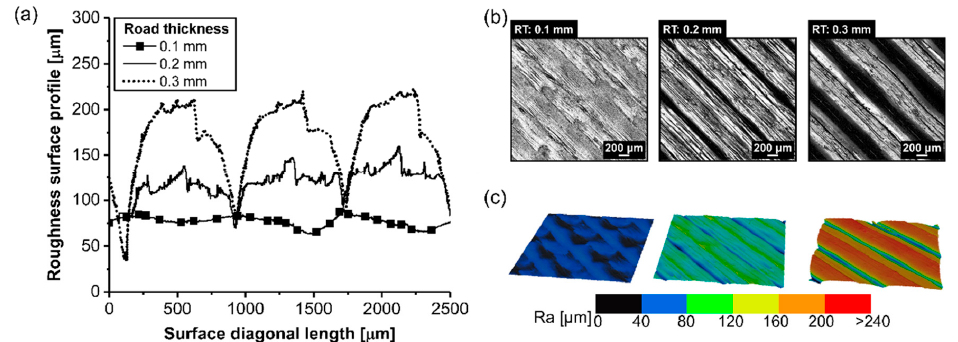
Figure 10. Influence of the surface roughness on the 3D-printed ABS for different road thicknesses ( a ) roughness surface profile, ( b ) surface image, and ( c ) 3D-image from the surface (condition four, RT: 0.1 mm; condition three, RT: 0.2 mm; condition five, RT: 0.3 mm; the following parameters PT: 280 °C, DS: 40 mm/s, AC: 15 wt.%, and NC: 2 were fixed for the conditions investigated).